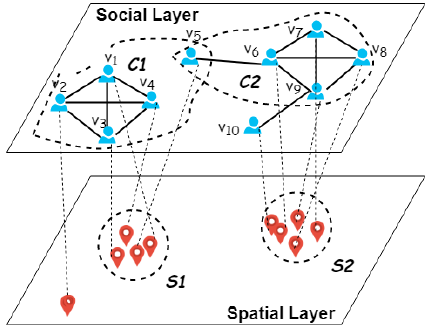
Figure 1. Example of a location-based social